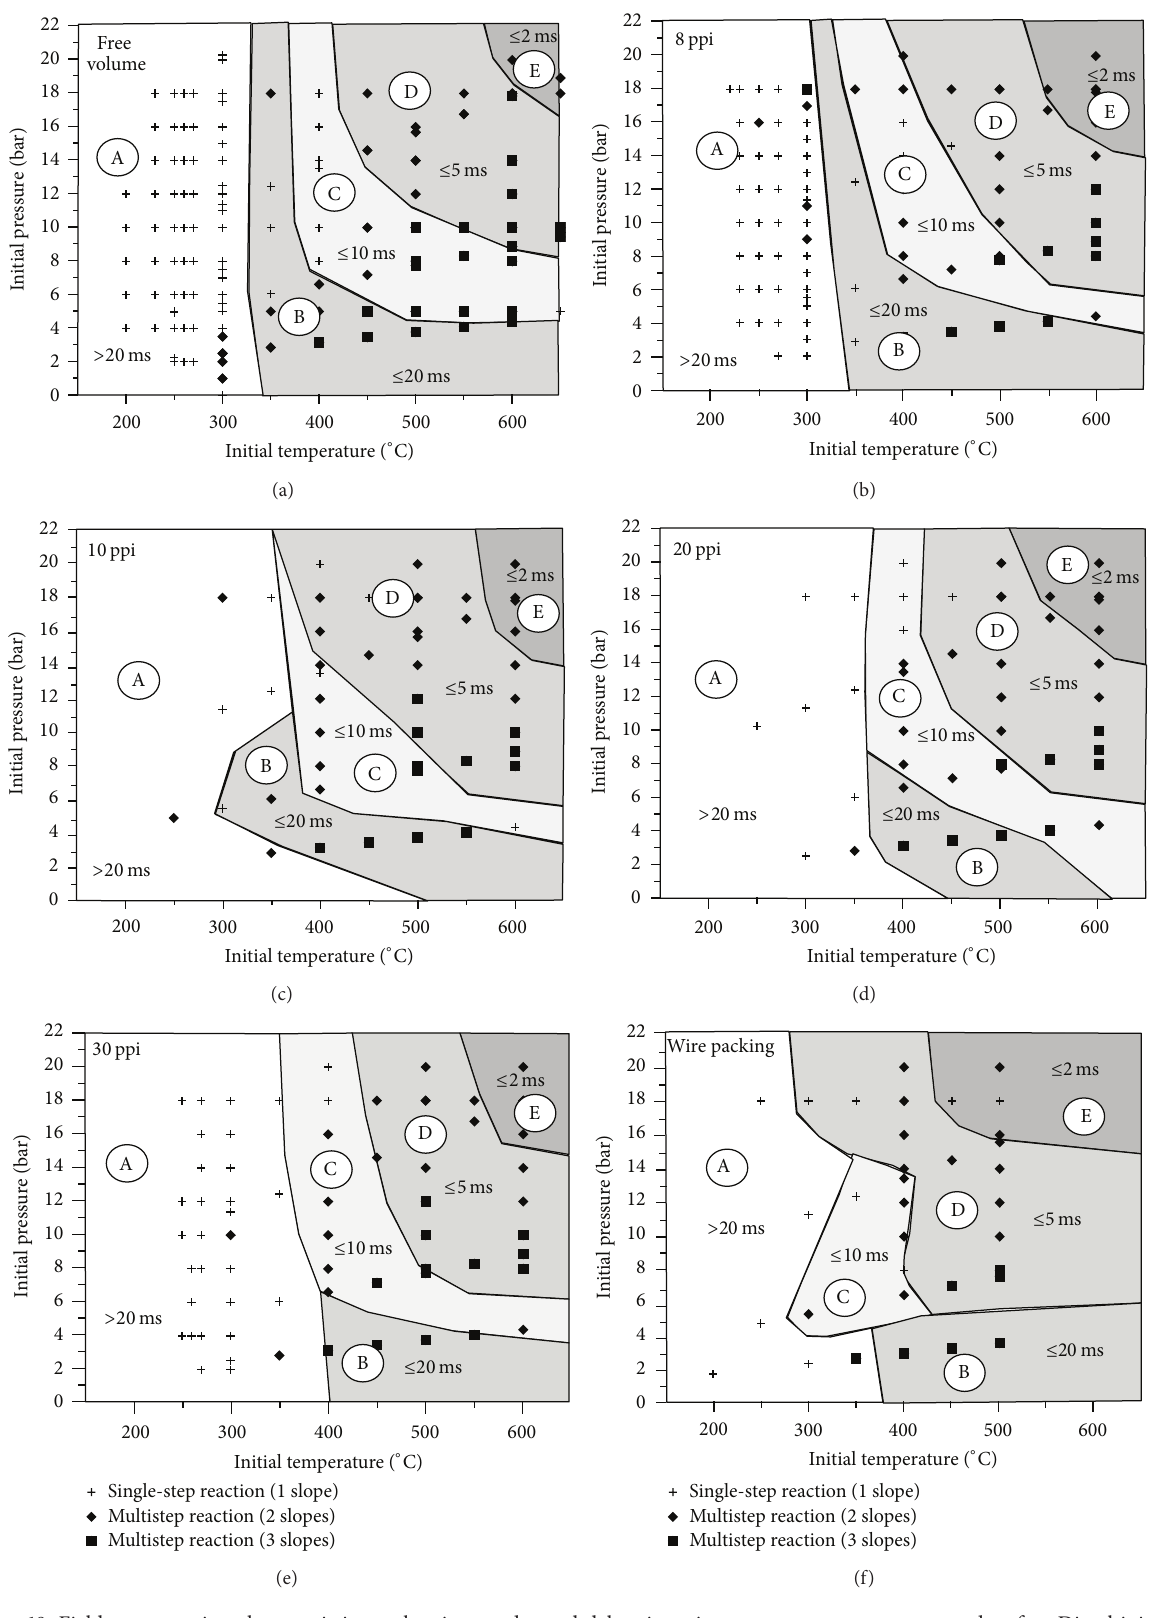
Figure 18: Fields representing characteristic combustion modes and delay times in porous reactors as compared to free Diesel injection